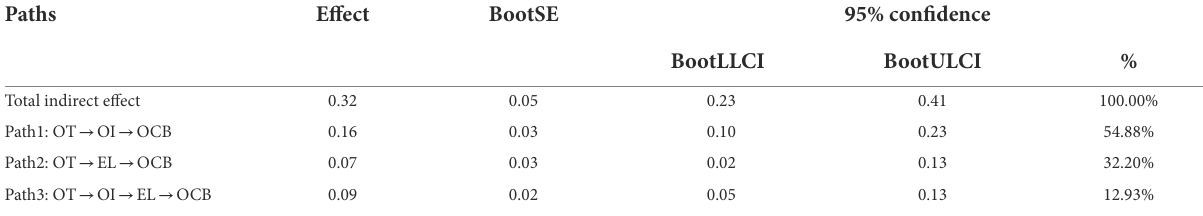
TABLE 5 Results of indirect